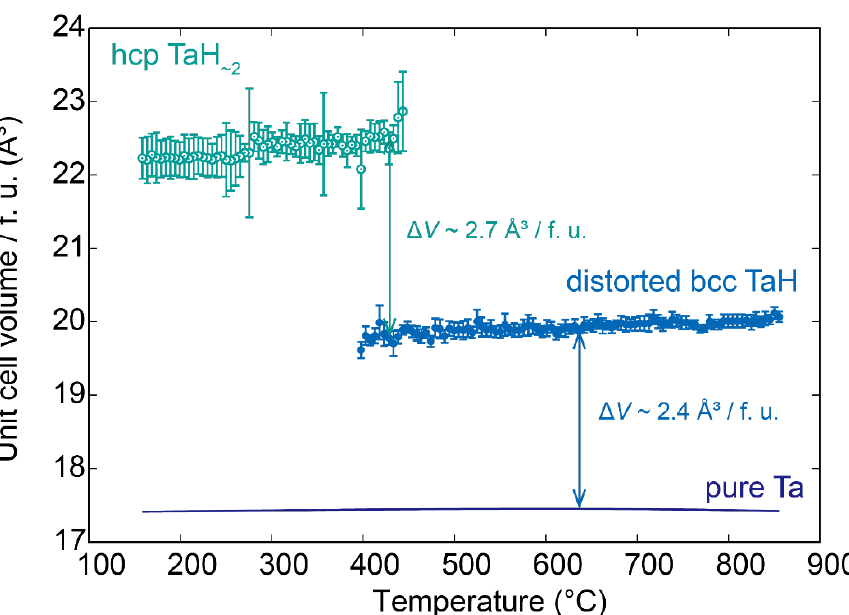
Figure 4. Unit cell volume of distorted bcc TaH and hcp TaH ~2 , obtained during a cooling run at a pressure range from 9.35 GPa to 8.36 GPa. Unit cell volume of pure Ta at the same pressure – temperature conditions are shown by the solid curve.